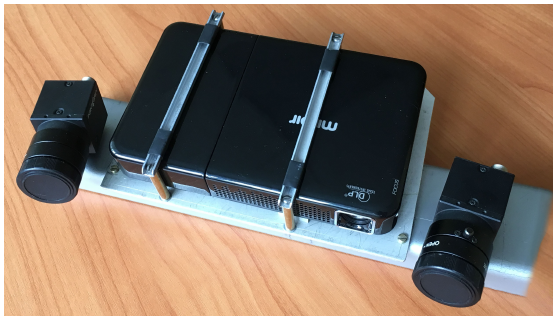
Figure 3. Mobile structured light 3D